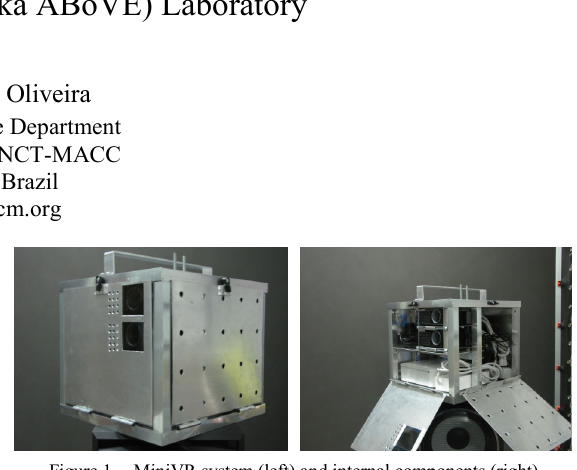
and cooling solution. Figure 1 shows the MiniVR system, including a quick glance on its internal